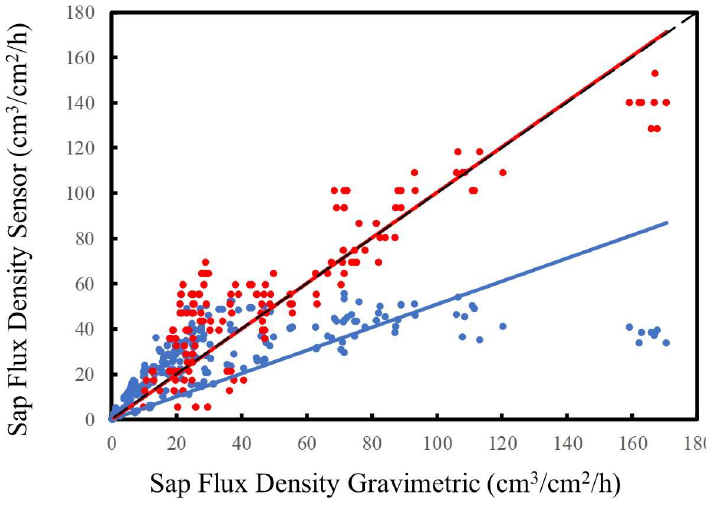
Figure 3. Correlation between gravimetrically determined sap flux density ( J s ) and J s measured via HRM/SRFM (blue) and Tmax (red). The slope and R 2 results are displayed in Table 2. The dashed black line is the 1:1 relationship.